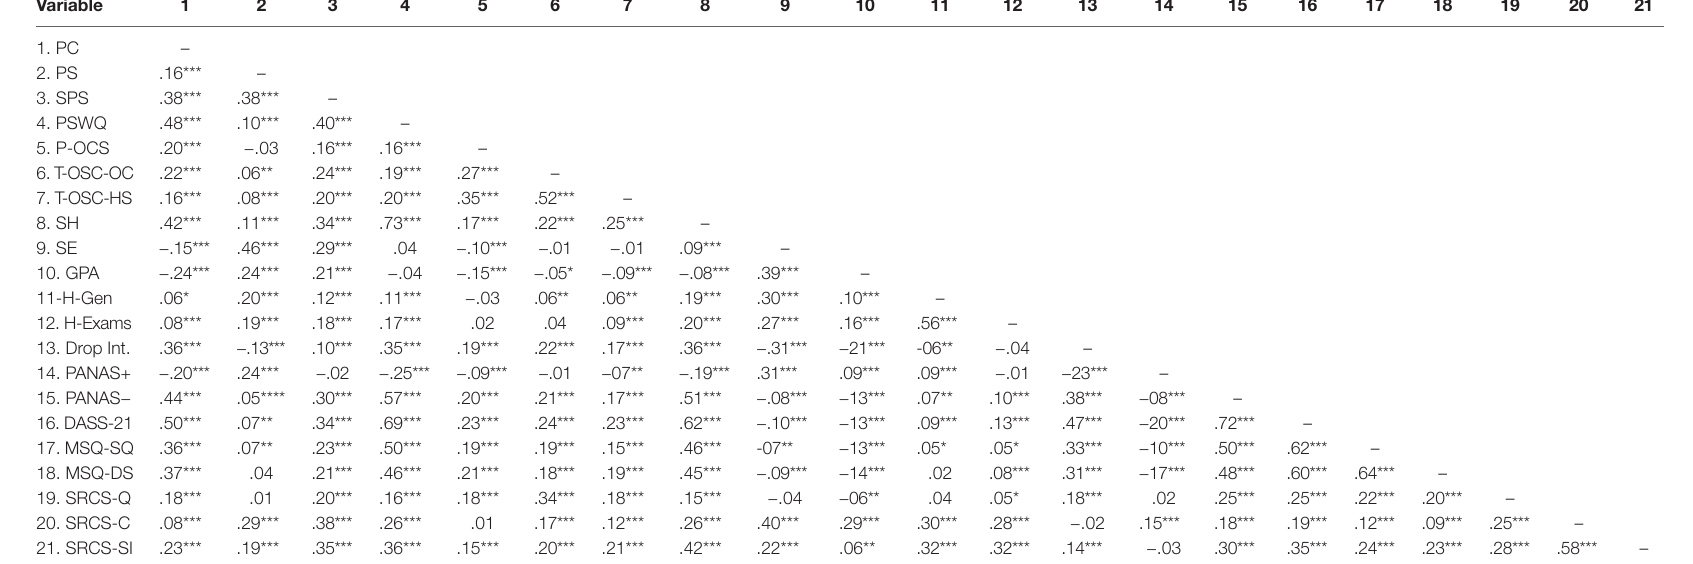
TABLE 4 | Zero-order correlations for study variables (n =